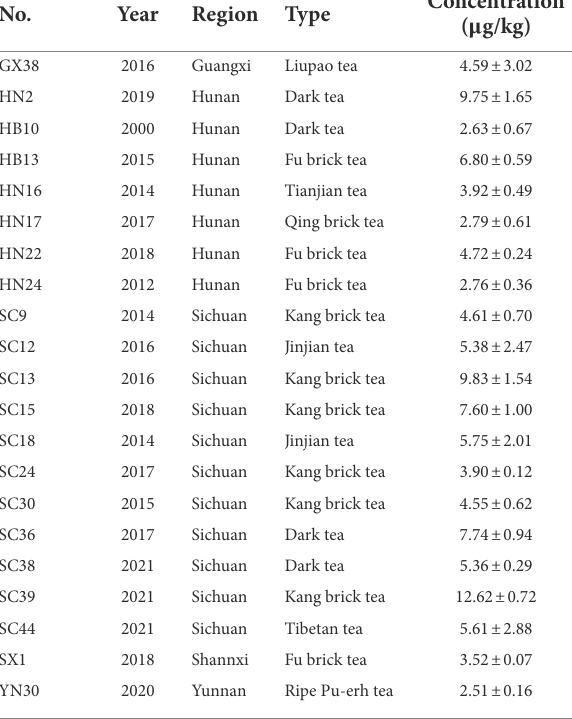
TABLE 1 OTA concentrations above LOQ of dark tea samples from different regions and